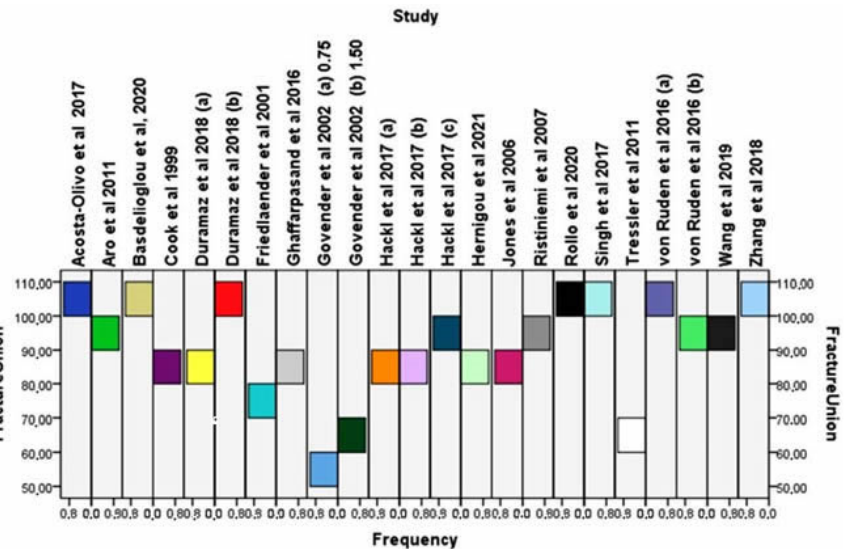
Figure 2. Prevalence of long bone fracture unions after the application of osteoinductive factors extracted from published bibliography [21–38].